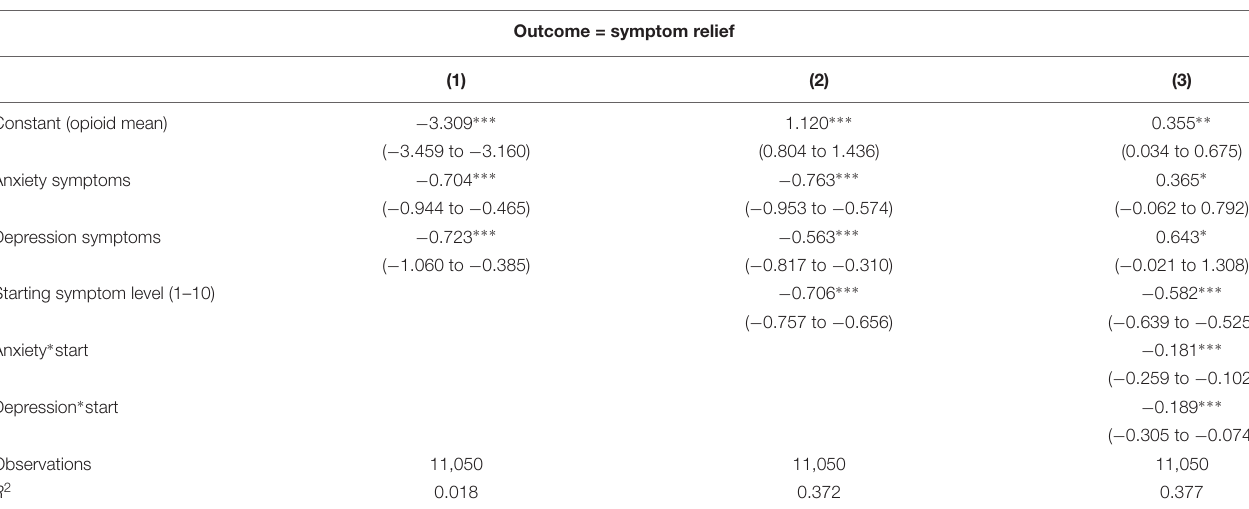
TABLE 2 | Reported symptom relief for users treating anxiety, pain, and